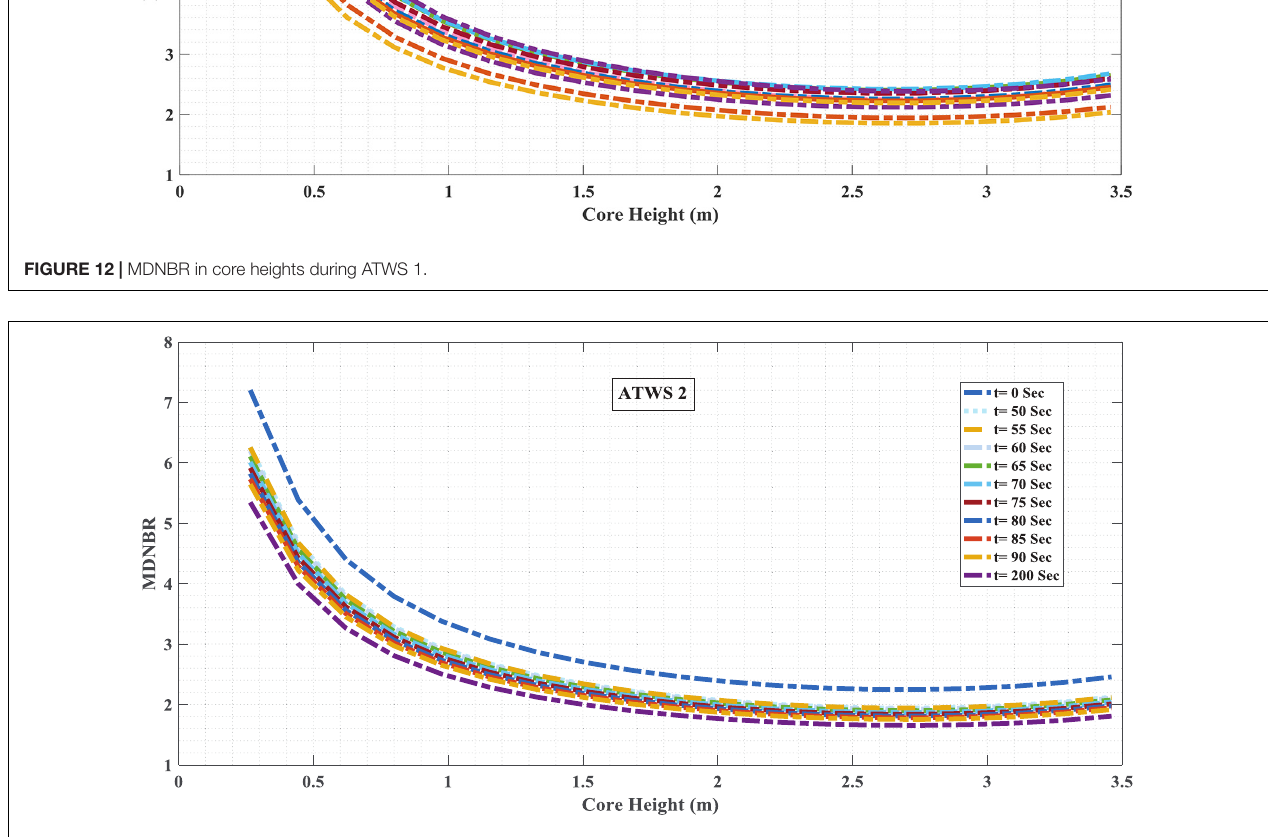
FIGURE 13 | MDNBR in core heights during ATWS